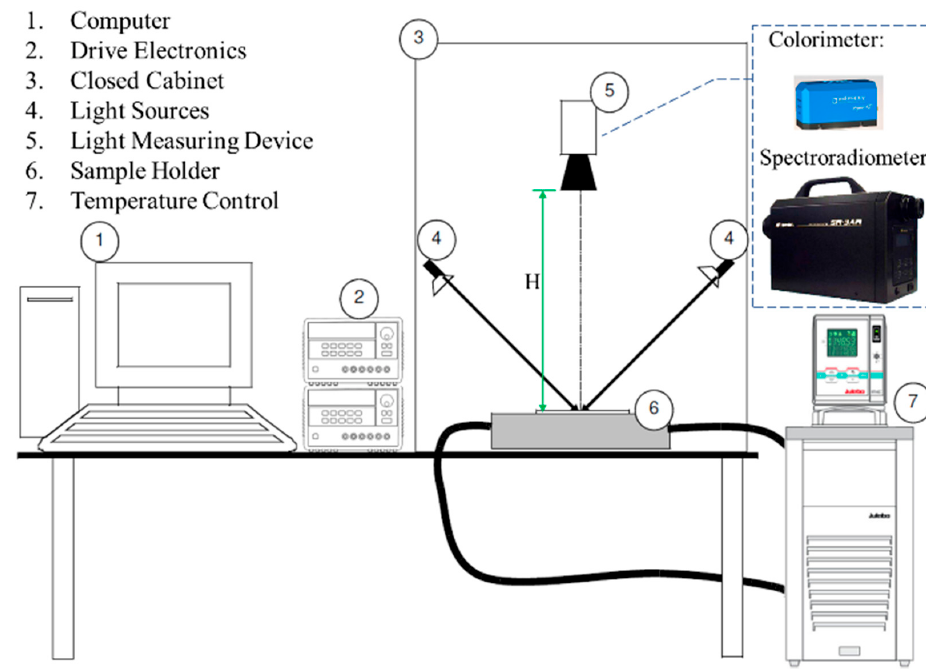
Figure 5. Layout diagram of EWD electro-optical measurement setup.